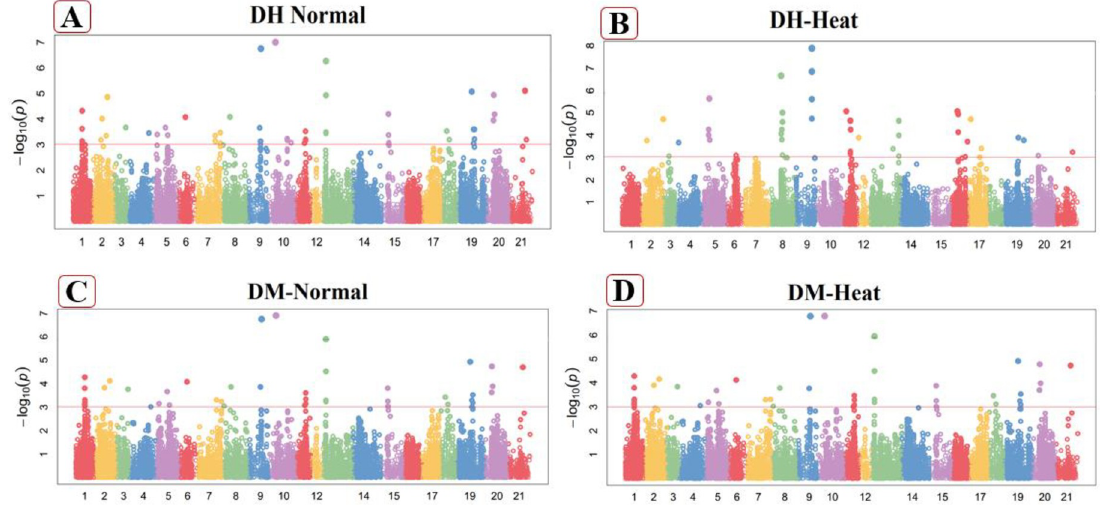
Fig 3. Manhattan plot of Days to heading (DH) in normal ( A ), heat stressed ( B ) conditions and Days to maturity (DM) under normal ( C ), heat stressed ( D ) conditions. These figures exhibiting the position of significant SNPs and -log10(p) linked with specific traits in normal and heat stressed